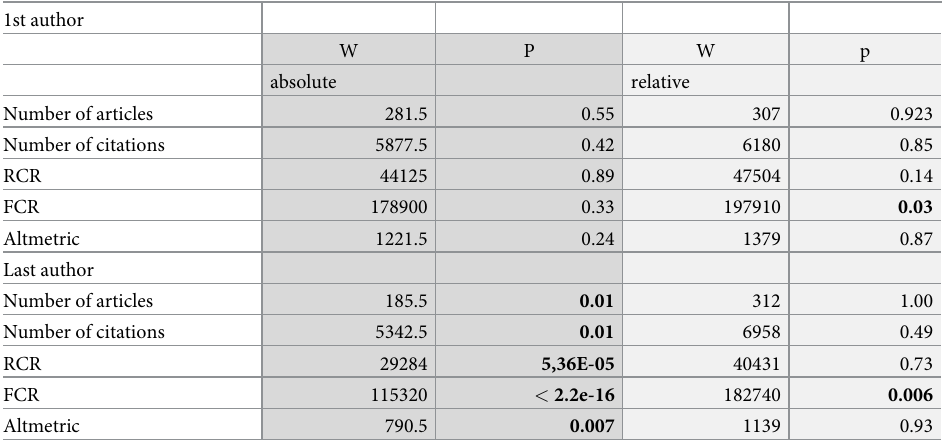
Table 4. Traditional and alternative metrics of research papers considering absolute vs relative values between sexes in 1,295 International journals with Entomological keywords in the paper